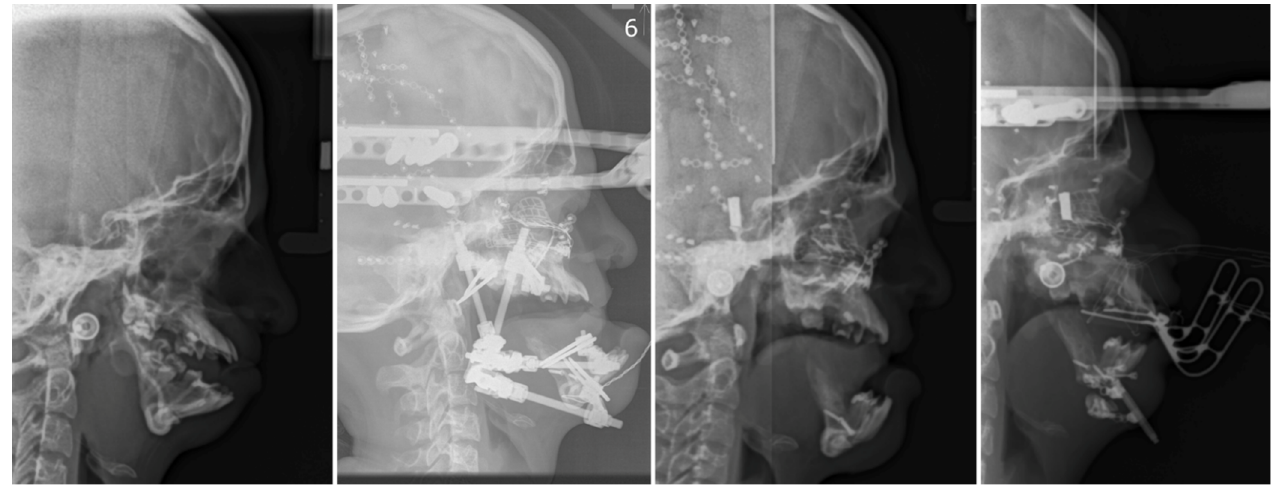
Figure 3. Cephalometric radiographs showing the basic steps of treatment related to the process of mandibular and maxillary osteodistraction aimed at improving facial contour and opening the upper airway.